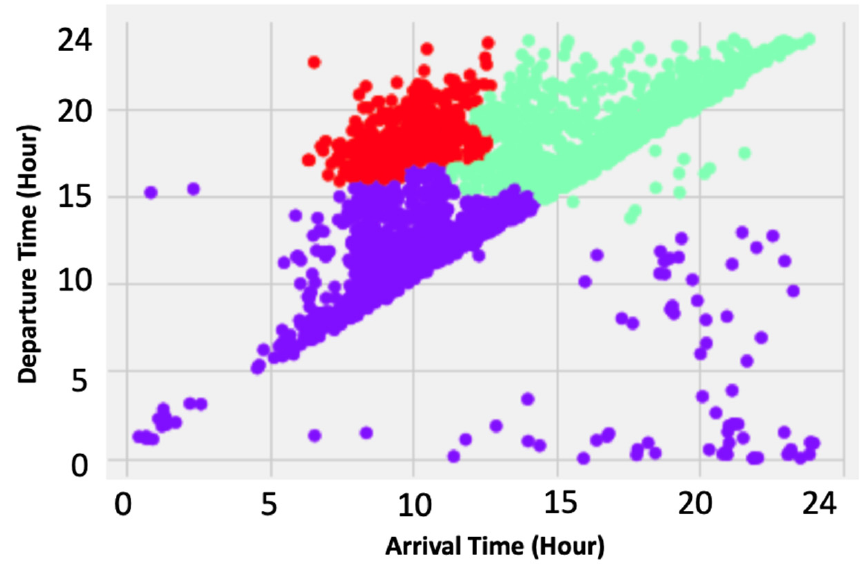
Figure 7. Cluster visualization for hierarchical agglomerative.